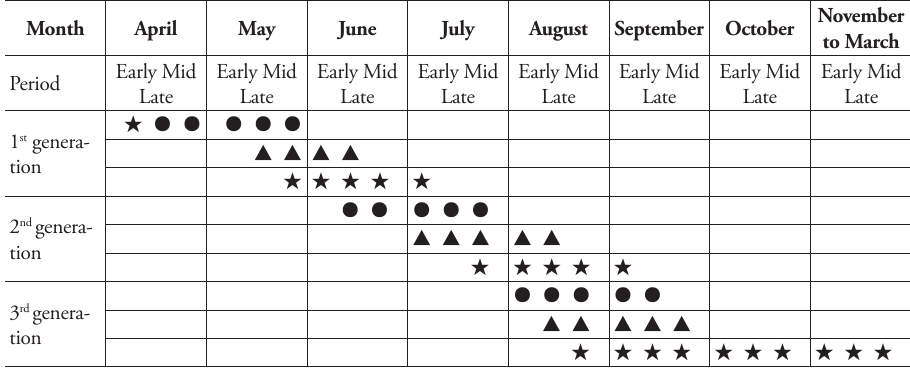
Table 1. Life history of Zyginidia eremita in Anningqu, Urumqi, Xinjiang. ● Egg ▲ Nymph ★